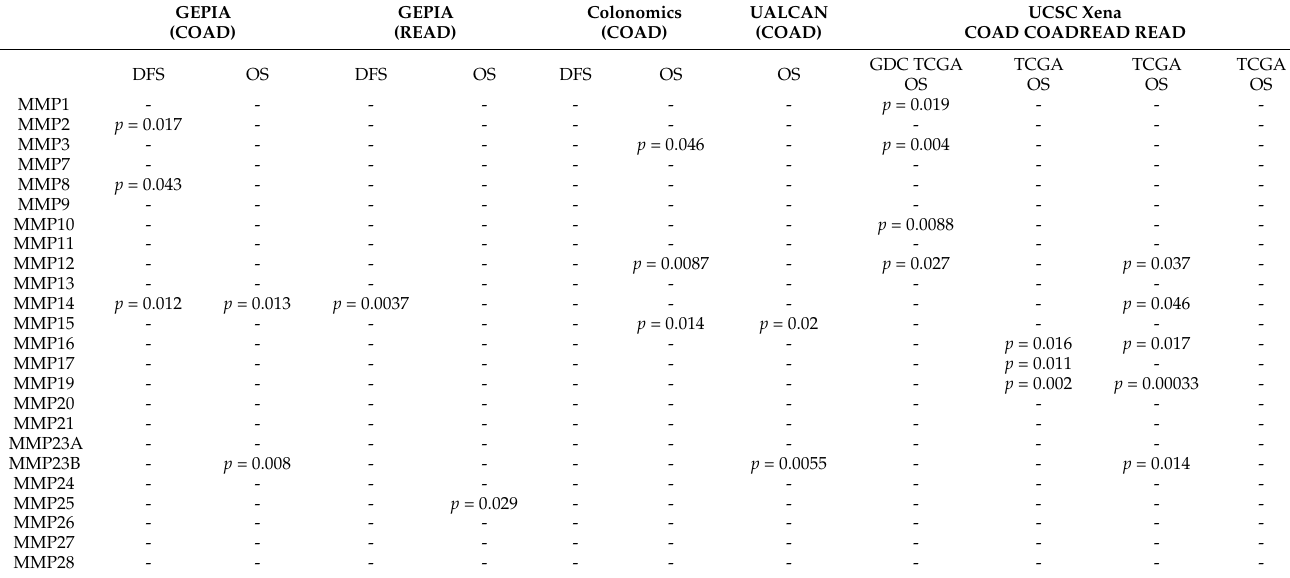
Table 3. Prognostic analysis of MMPs in CRC evaluated by GEPIA, Colonomics, UALCAN, and UCSC Xena. The p -value was marked in red when higher expression of selected MMP was associated with poor prognosis and in the black when higher expression of selected MMP was associated with a good prognosis. Colon Adenocarcinoma datasets (COAD), Colon and Rectal Adenocarcinoma datasets (COADREAD), Disease-free survival (DFS), and overall survival